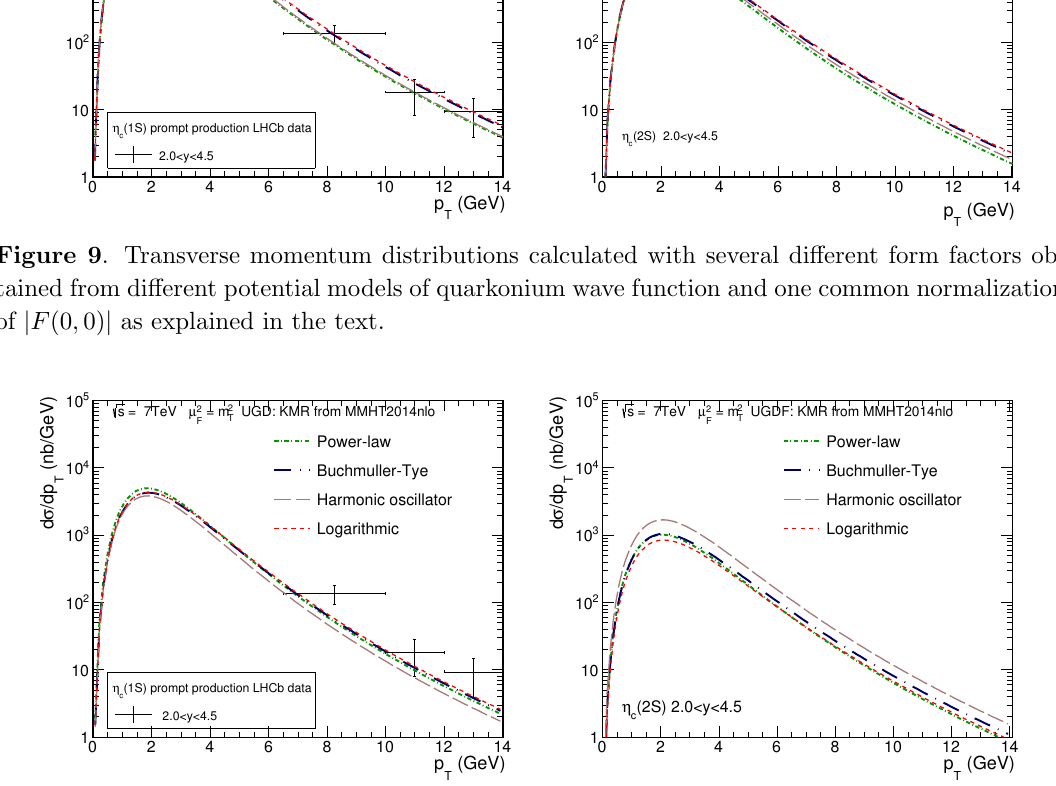
Figure 10 . Distributions calculated with several di(cid:11)erent form factors obtained from di(cid:11)erent potential models of